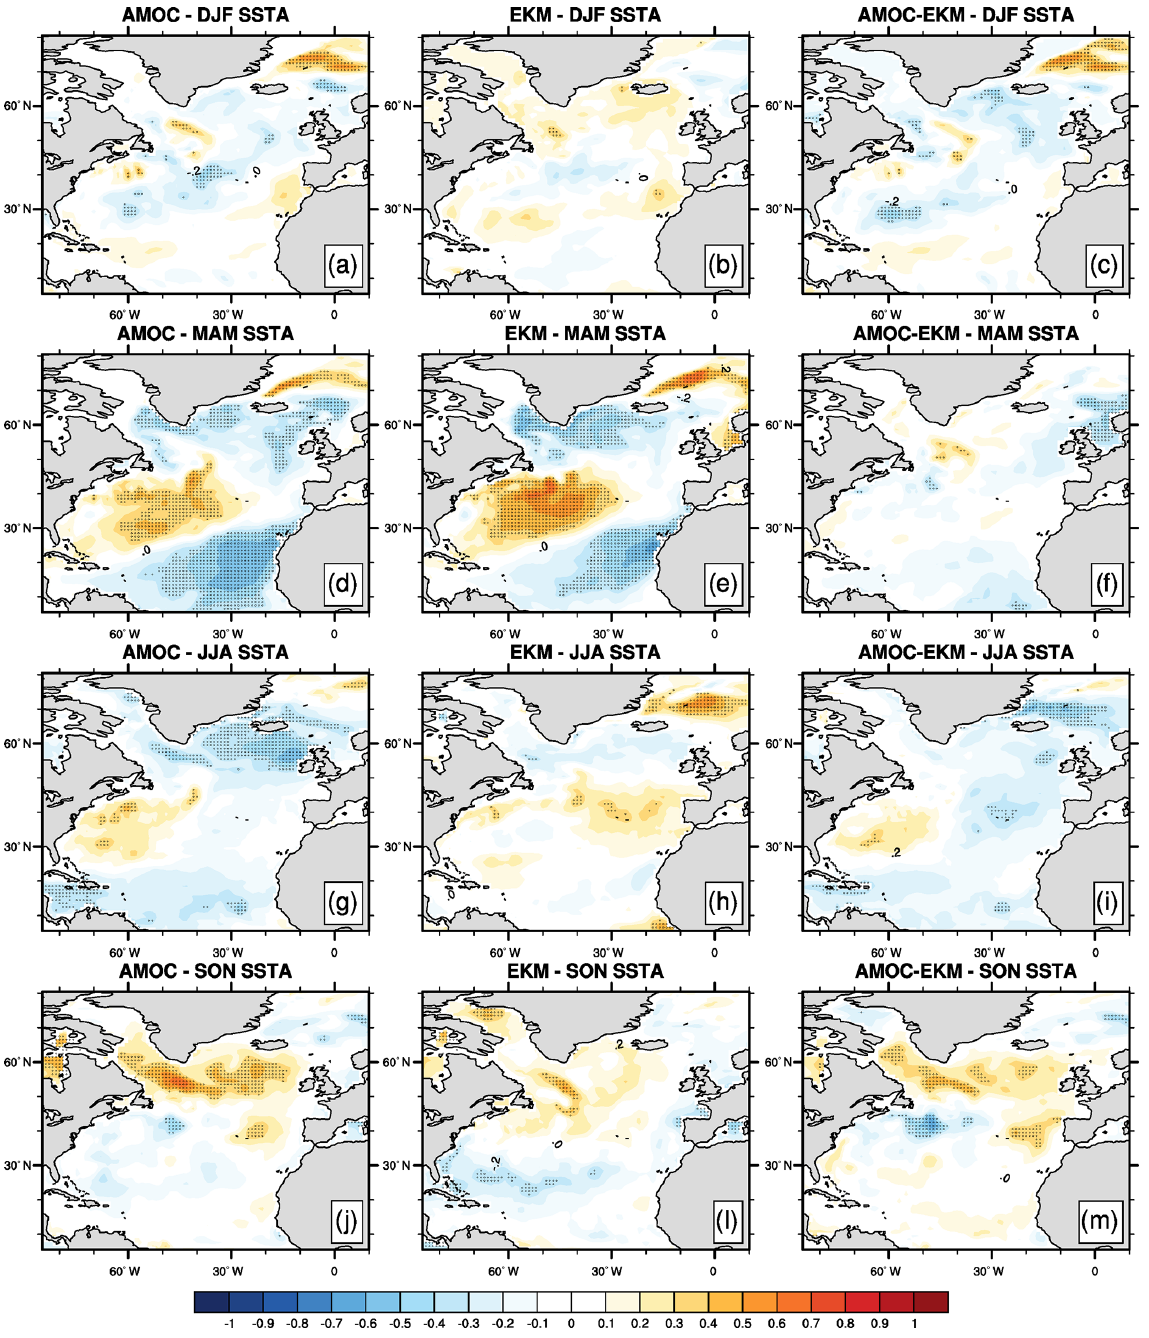
Figure 7. Correlations between SST seasonal means and the AMOC (a, d, g, j) , EKM (b, e, h, l) and AMOC-EKM (c, f, i, m) at a 2–4- month lag (with the transport leading SST) covering the 1979–2014 period in the assimilation experiment. The stippling represents significant correlations at the 95% confidence level, calculated from 1000 bootstrap